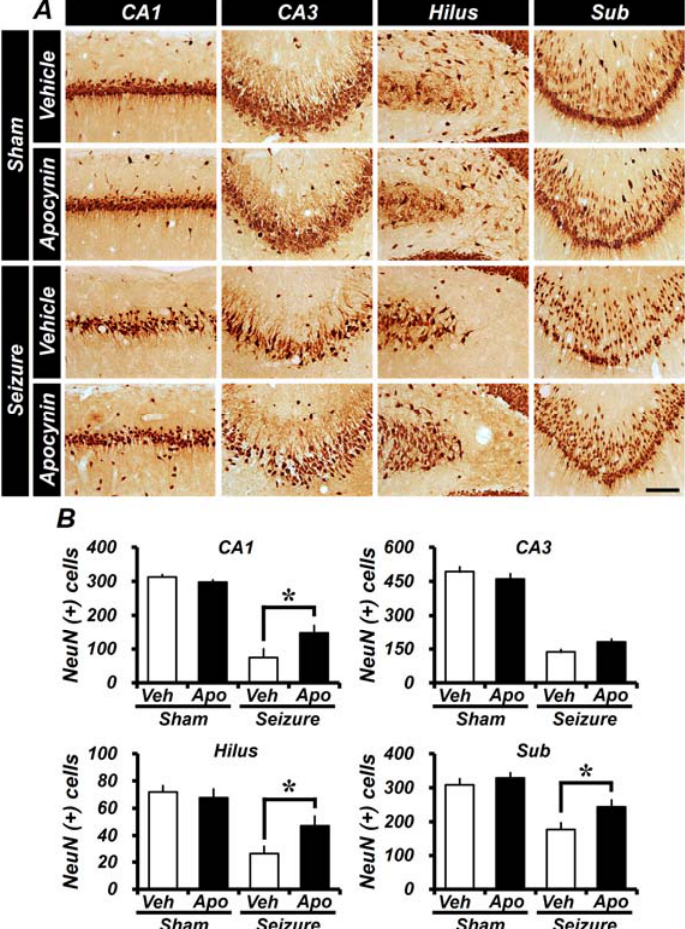
Figure 1. Treatment with apocynin for a week reduces seizure-induced neuronal cell death. Anti-neuron nuclear antigen (NeuN) staining was performed to identify live neurons. ( A ) A micrograph showing live neurons in the sham group, the seizure control group, and the apocynin treatment group. Apocynin treatment shows a substantially increased number of NeuN + cells in the hippocampus of the seizure group. Scale bar = 100 µ m. ( B ) The graph shows the average number of live neurons (NeuN + cells) in the hippocampus after seizure compared to the apocynin treatment group. Data: mean ± standard error of the mean (S.E.M.), n = 5–6 from each group. * p < 0.05. CA3 is not statistically significant. Veh = Vehicle; Apo = Apocynin; CA1 and CA3 = Cornu Ammonis 1 and 3 of the hippocampus area; Sub = Subiculum.